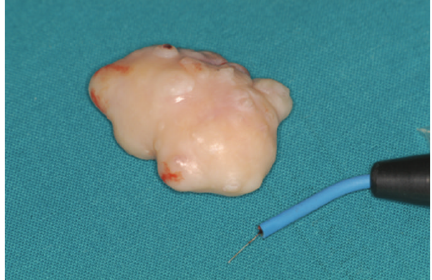
Figure 3: Aspect of the surgical specimen (Bladion©, length of cutting tool = 4